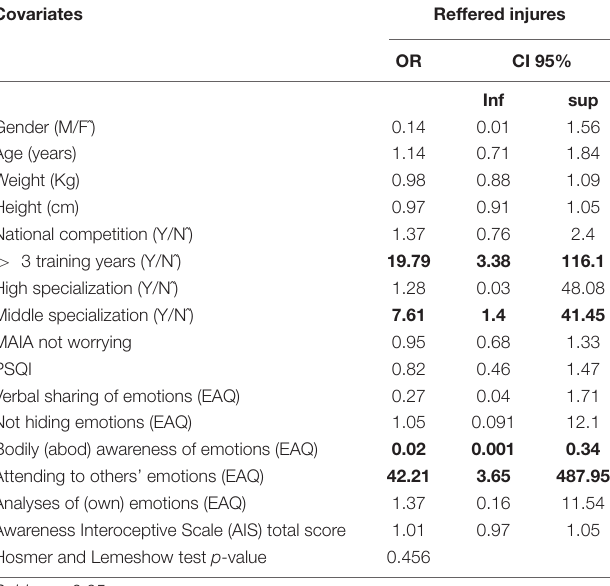
TABLE 3A | Regression model of “Reffered injures”.